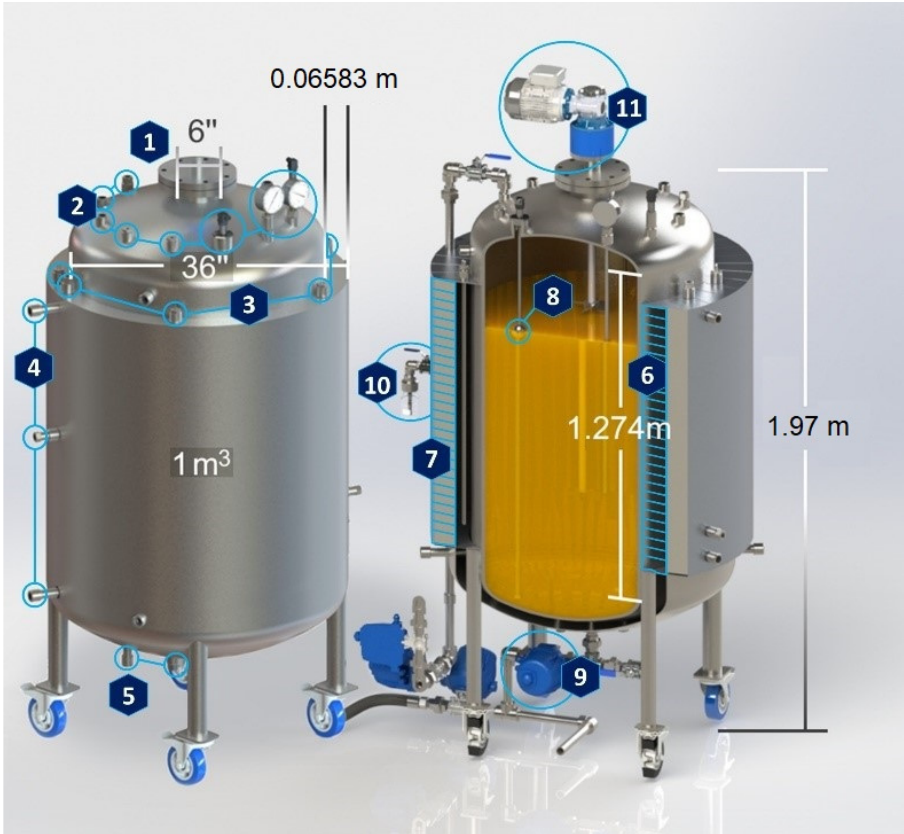
Figure 2. Experimental schematic of the bio-reactor.